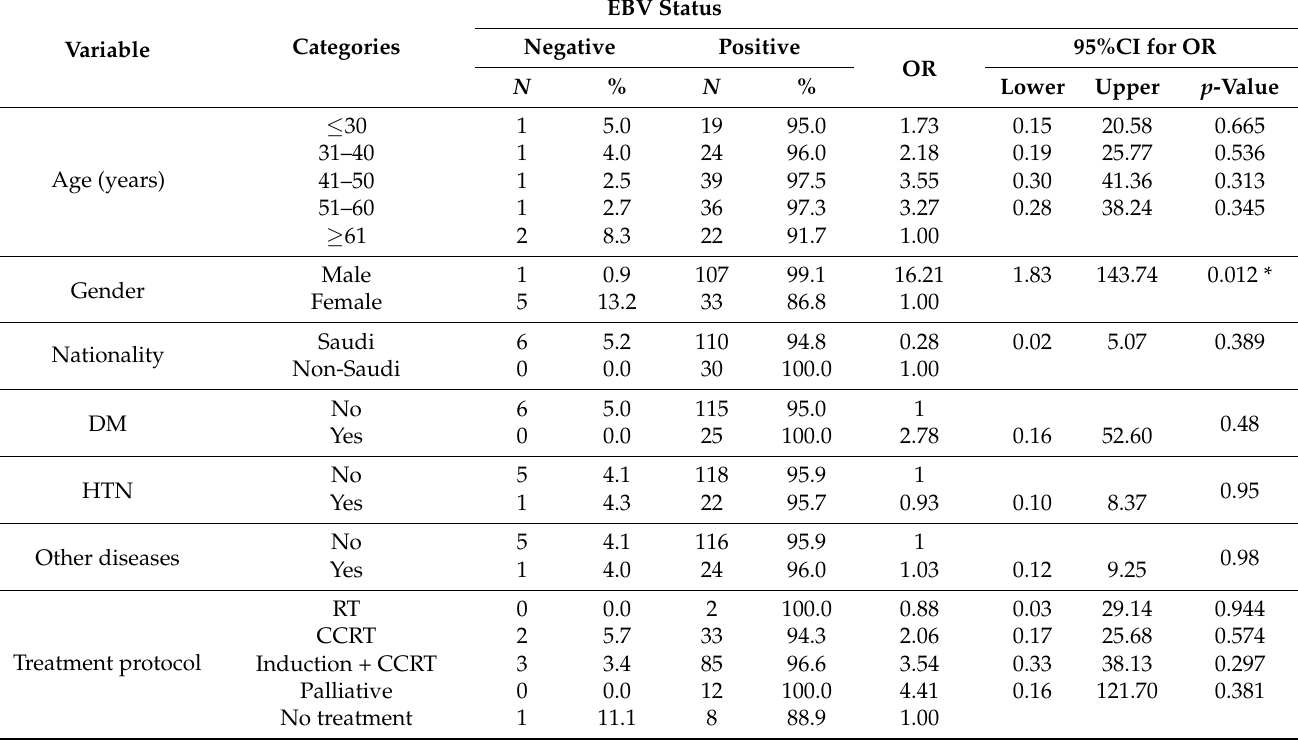
Table 3. Association between EBV status and patients’ baseline